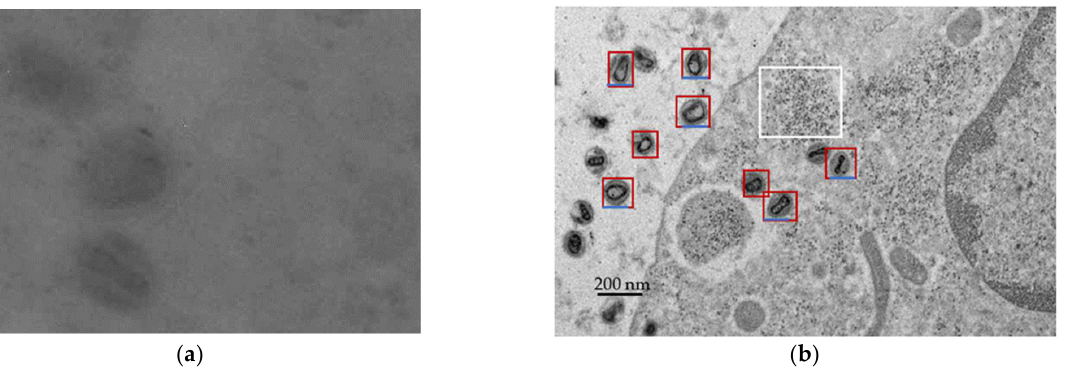
Figure 1. Transmission electron microscopy micrographs; ( a ) a control image without SPIO-NP. ( b ) AMNP-labeled M2 macrophages revealing the intralysosomal localization of nanoparticles or microvesicles (100 nm–1 μm), which directly bud from the plasma membrane. The red box englobes a lysosome or a microvesicle. The black scale bar on the left corresponds to 200 nm, and the blue scale bar represents 100 nm.